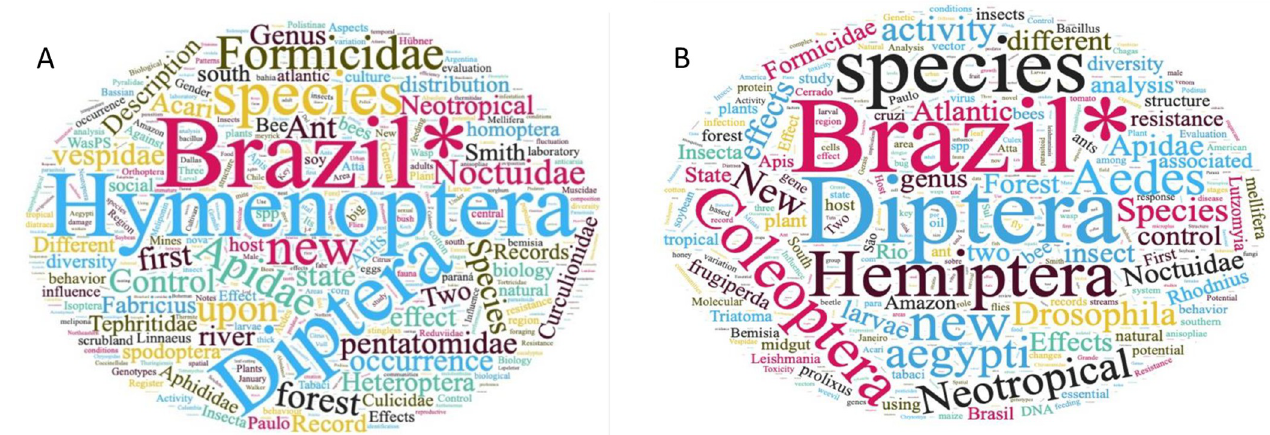
Fig 2. Word Cloud of the most frequent words on entomological articles found in the (A) Brazilian Entomology journals and (B) in international journals. Word size evidences the frequency of that word on paper titles. The � after Brazil denotes a suffix and thus includes Brazil and Brazilian.